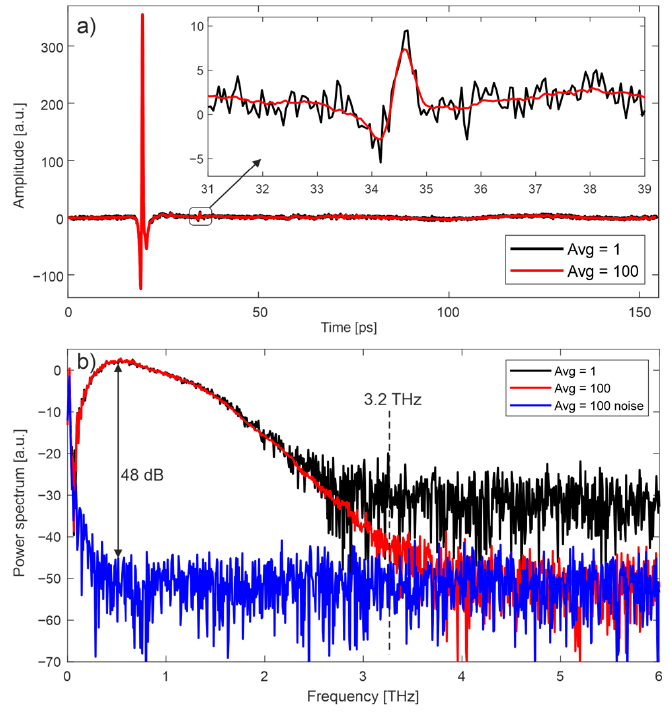
Figure 3. THz waveforms for averaging 1 and 100 ( a ) and their power spectra ( b ). Inset shows influence of averaging on the smoothing of the signal.